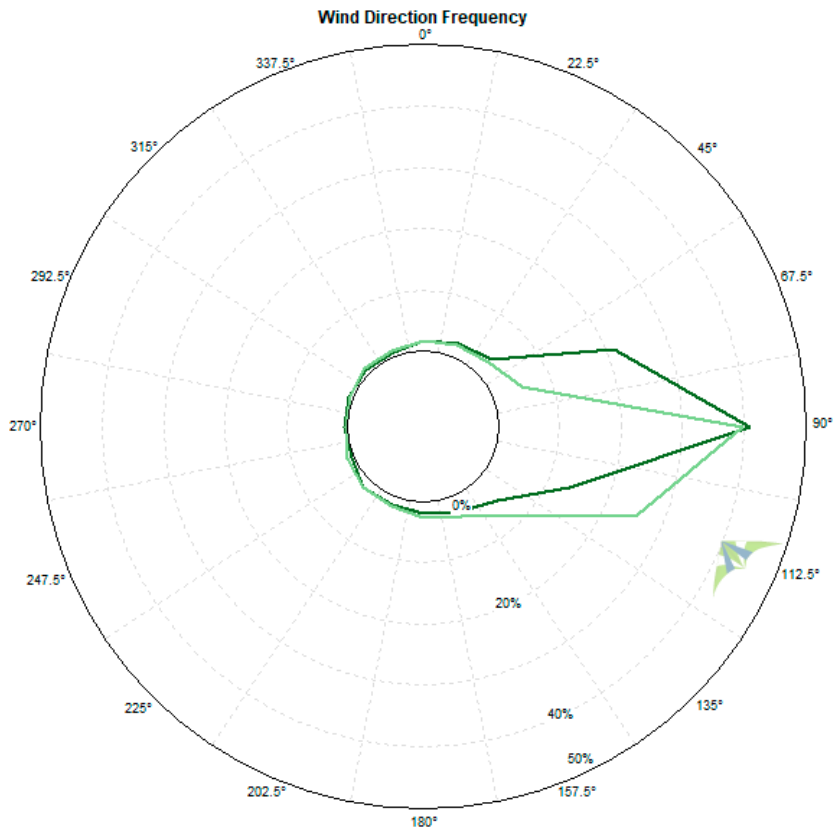
Figure 8. Wind direction frequency. Source: generated by the software.